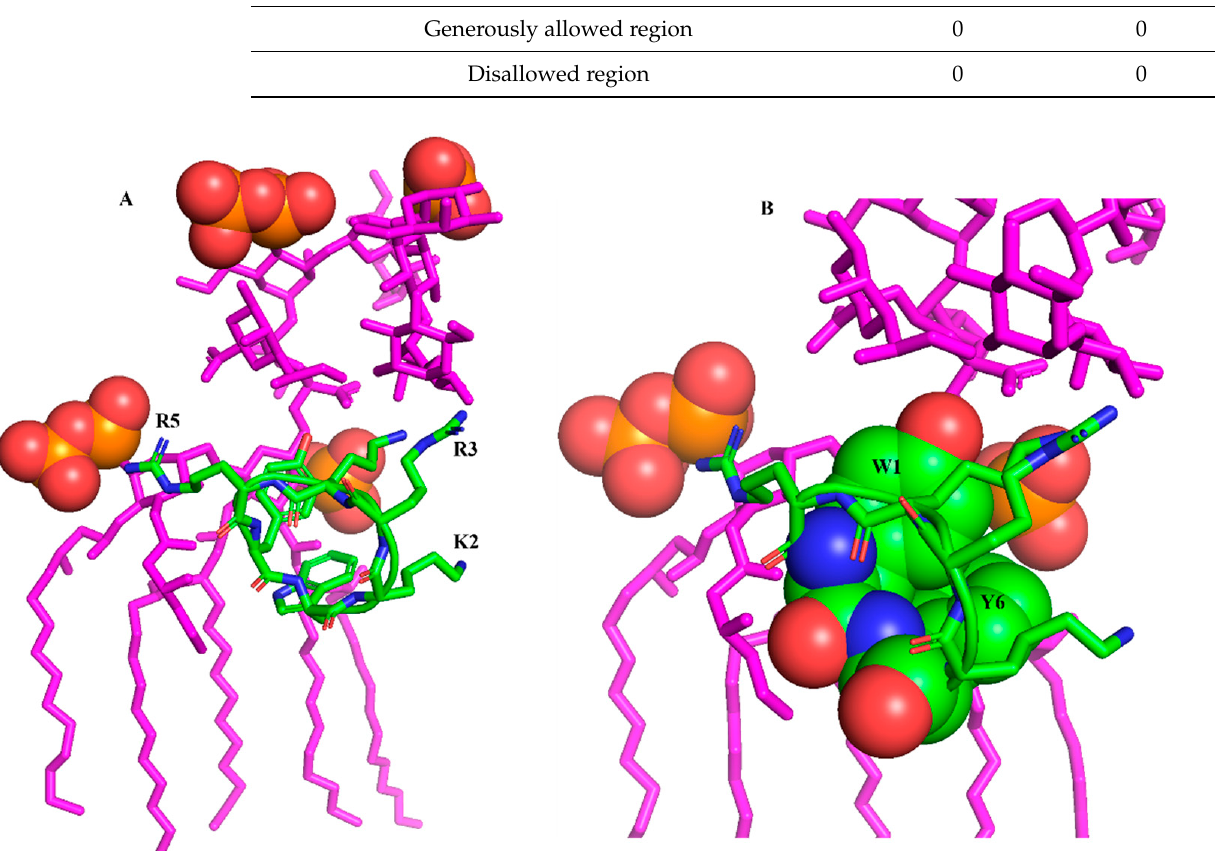
Figure 2. ( A ) Docked complex of cWY6 and LPS (magenta) showing potential molecular interactions.